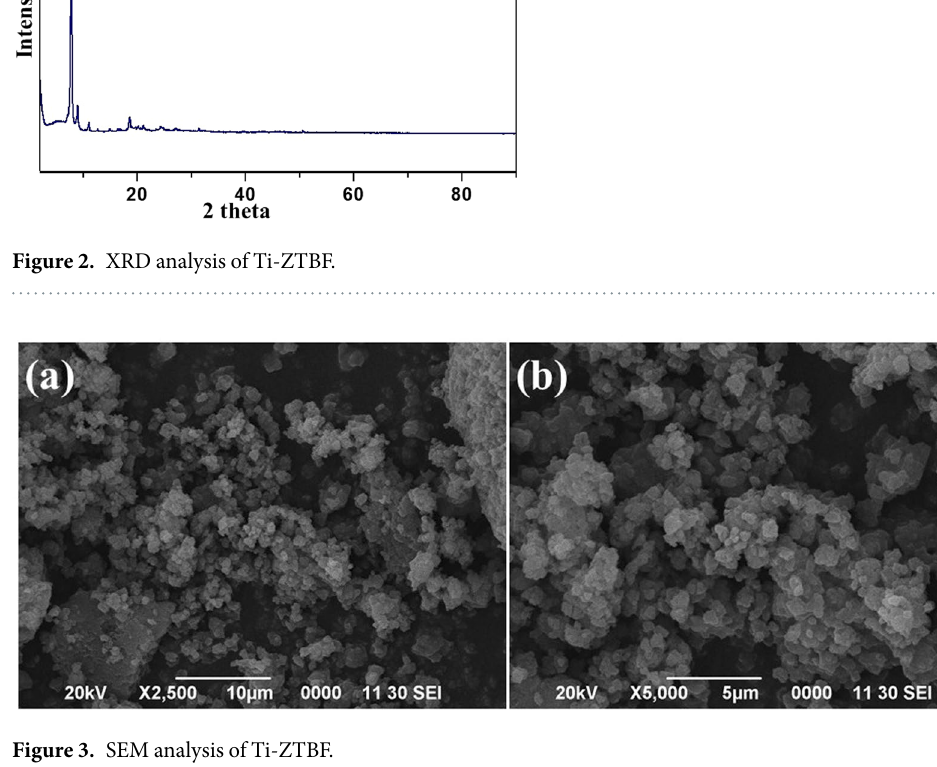
Figure 3. SEM analysis of Ti-ZTBF.